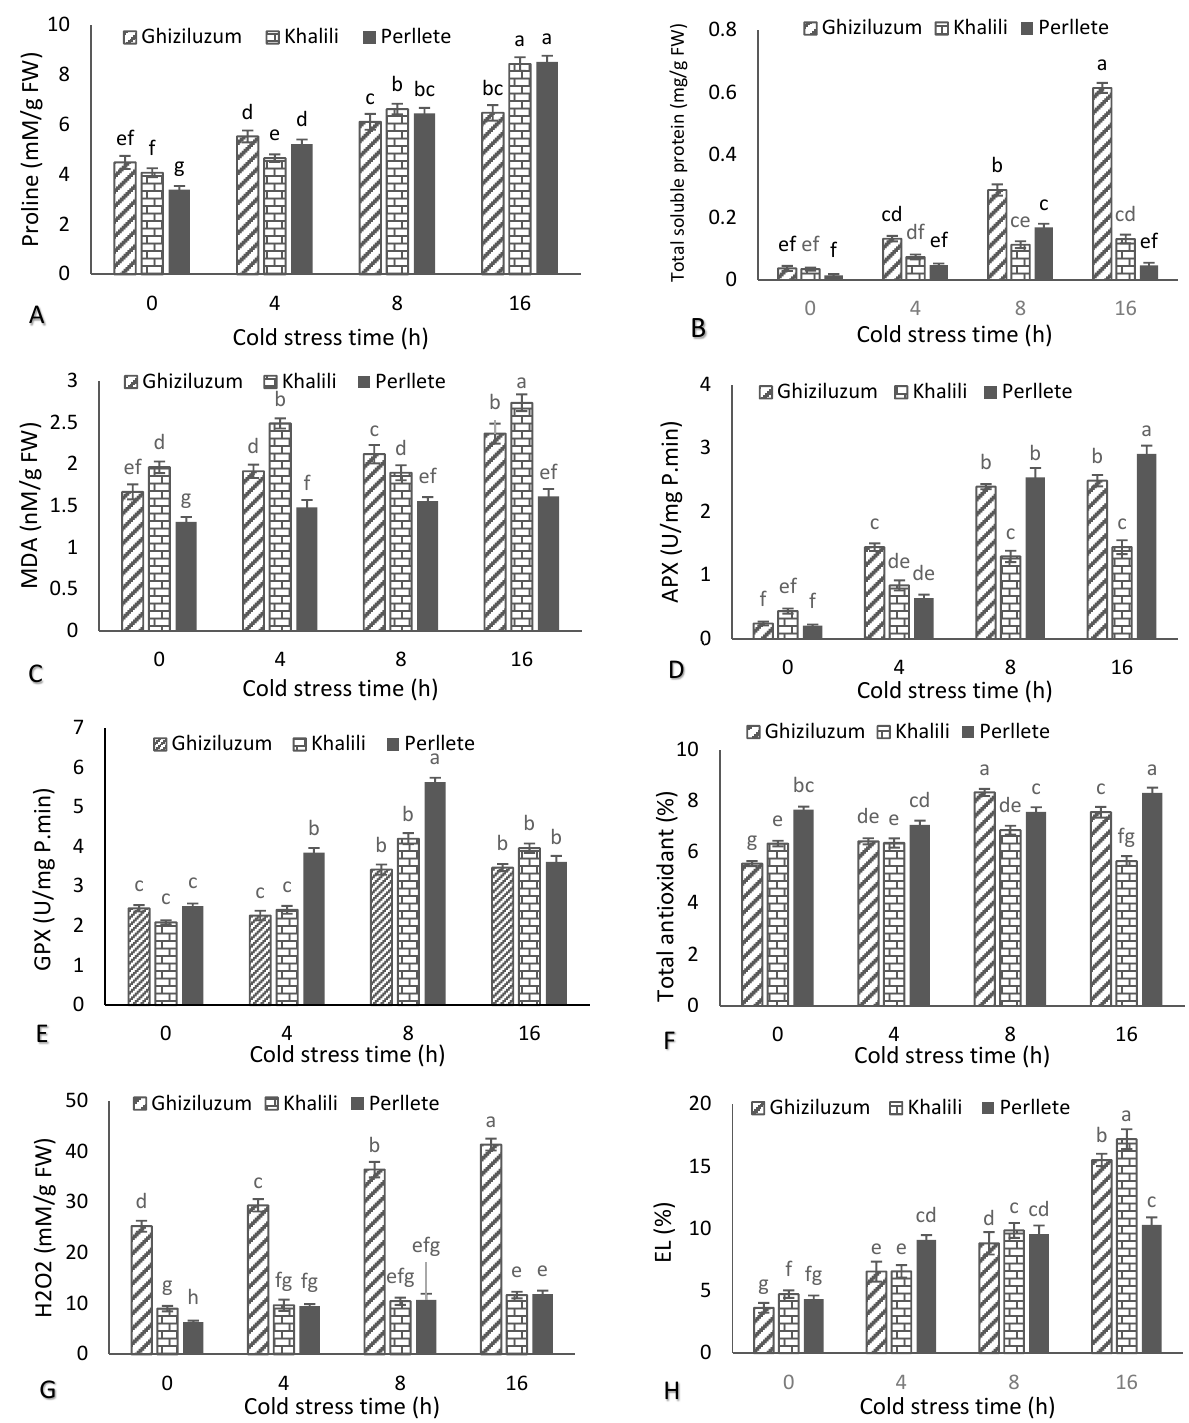
Figure 1. The effects of cold stress time-course on the proline content ( A ), total soluble protein ( B ), malondialdehyde (MDA) ( C ), ascorbate peroxidase (APX) ( D ), guaiacol peroxidase (GPX) ( E ), total antioxidants ( F ), H 2 O 2 ( G ) and electrolyte leakage (EL) ( H ) of three grapevine cultivars. Similar letters show no meaningful difference at 5% probability level by Duncan’s Multiple Range Test. Data are mean ± SD ( n =